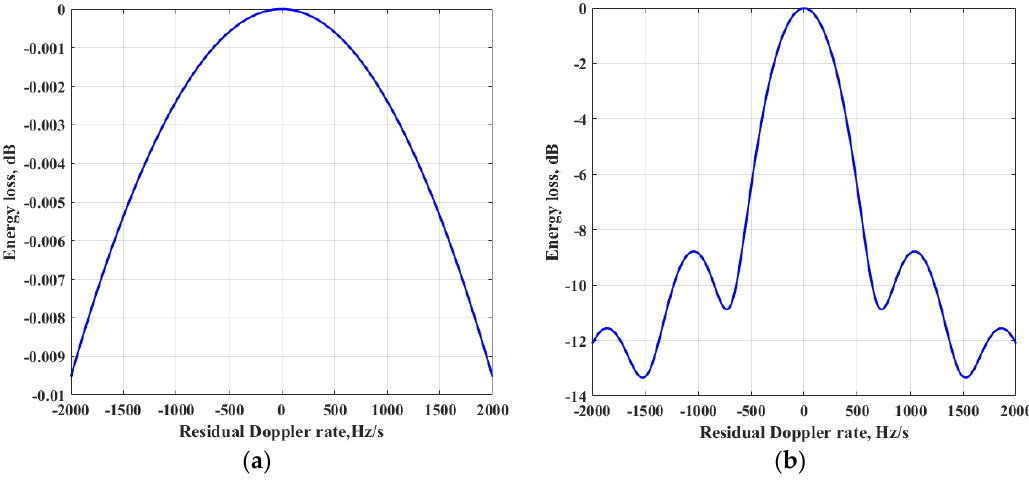
Table 1. Simulation parameters for 2D search approach. FFT: fast Fourier transform.